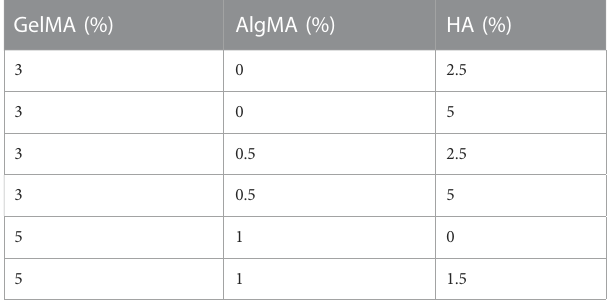
TABLE 1 Different formulations of hydrogels used in the optimization